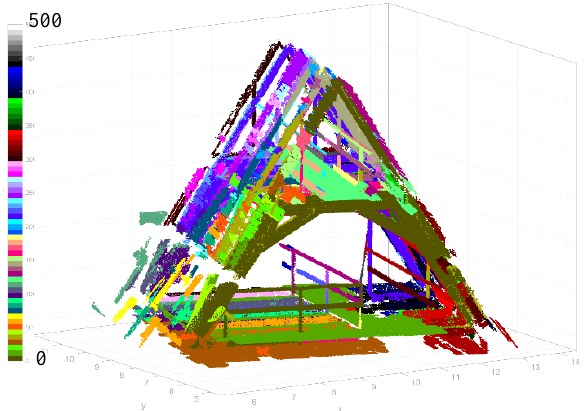
Figure 12: Results of the segmentation process